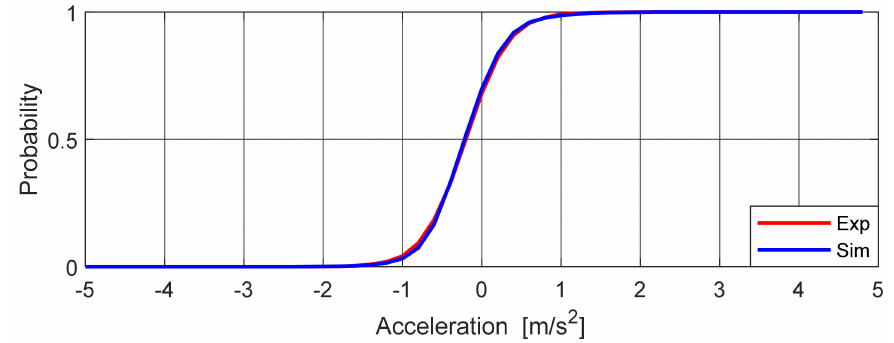
Figure 17. Distribution function, acceleration in vehicle